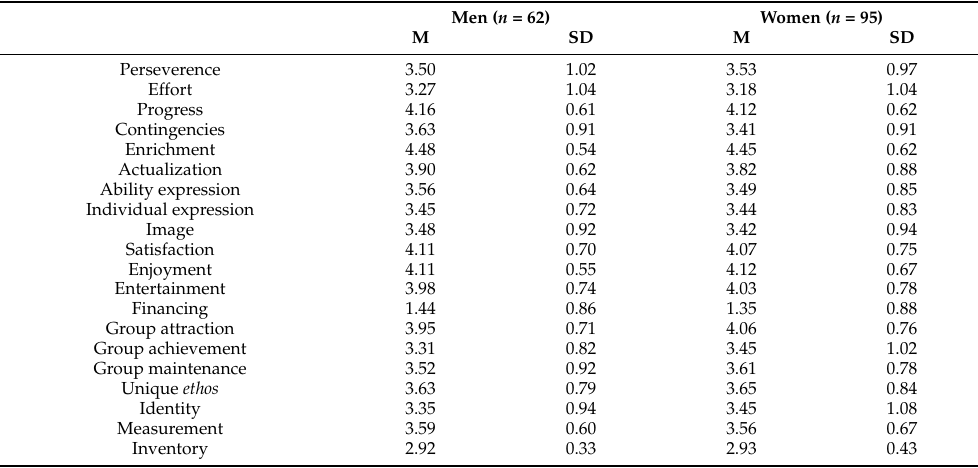
Table 4. Descriptive indicators for the dimensions, measurement and inventory models by gender.